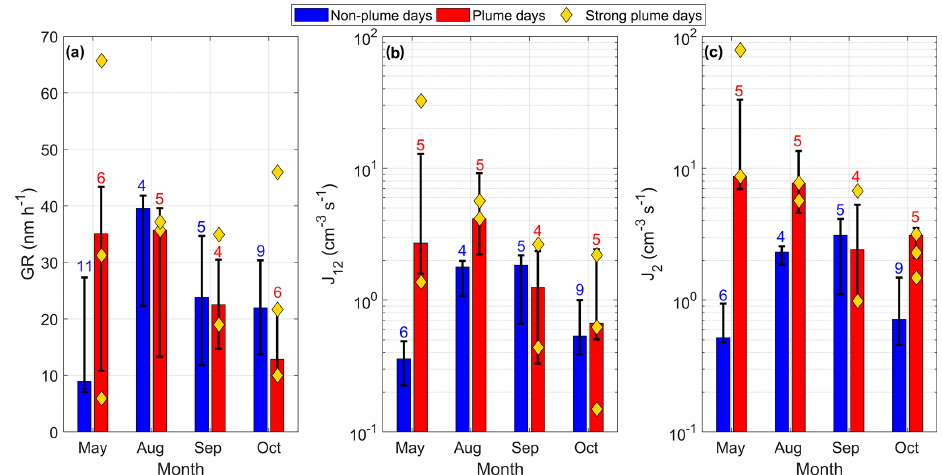
Figure 3. Monthly medians and percentiles of the NPF event characteristics observed on plume and non-plume days at Maïdo. (a) Particle growth rate between 12 and 19nm (GR 12 − 19 ). Formation rate of (b) 12 ( J 12 ) and (c) 2nm ( J 2 ) particles. The bars represent the median of the data, and the lower and upper edges of the error bars indicate 25th and 75th percentiles, respectively. Data collected on strong plume days are included in the statistics reported for plume days and are also highlighted separately. Numbers on each plot indicate, for plume and non-plume conditions, the total number of NPF events included in the